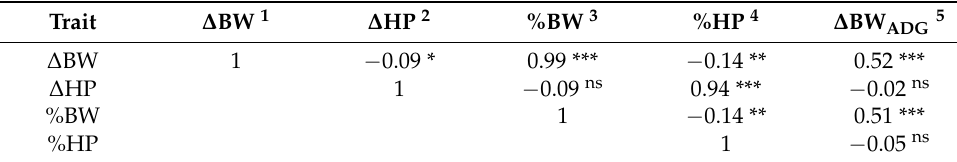
Table 3. Correlations between the resilience indicators.